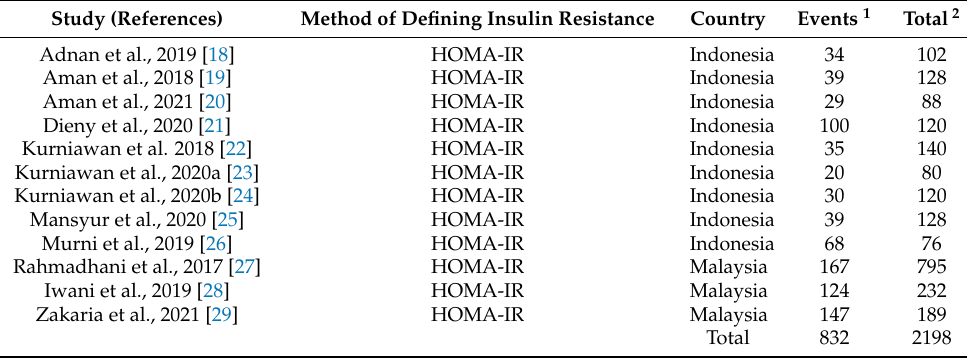
Table 1. The references and main attributes of included studies.